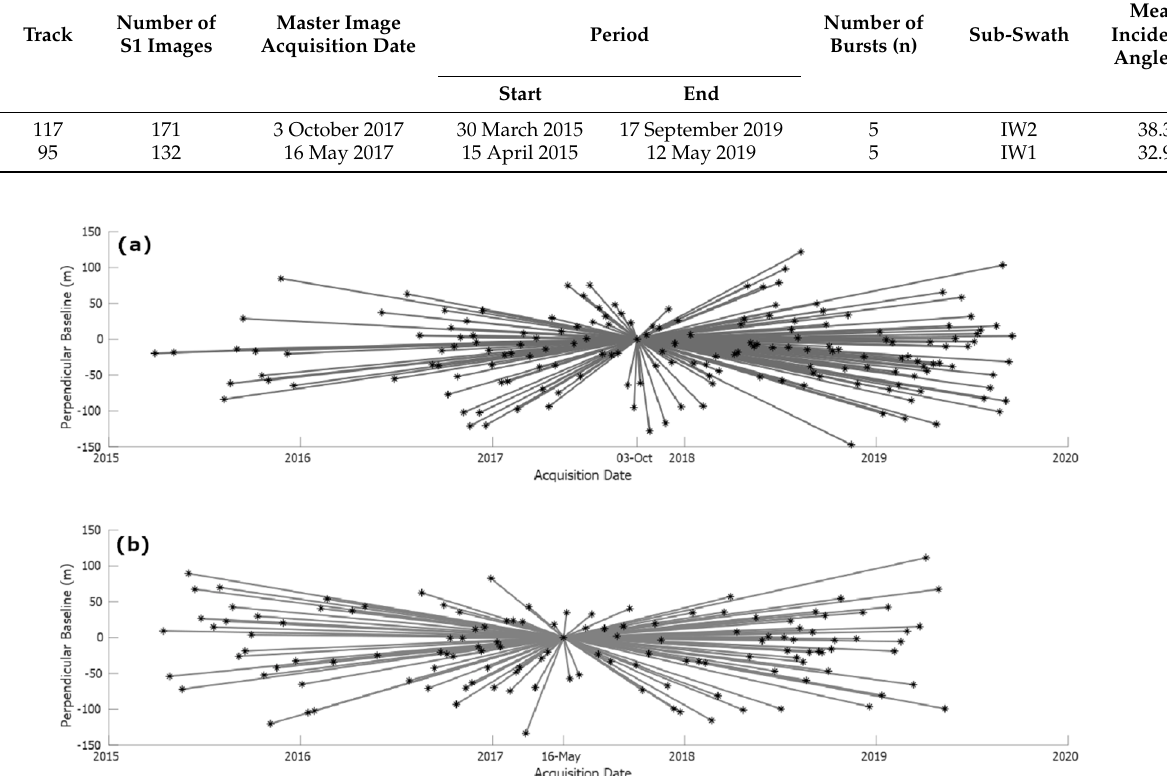
Figure 2. The temporal and perpendicular baselines for the ascending ( a ) and descending ( b ) S1 datasets.